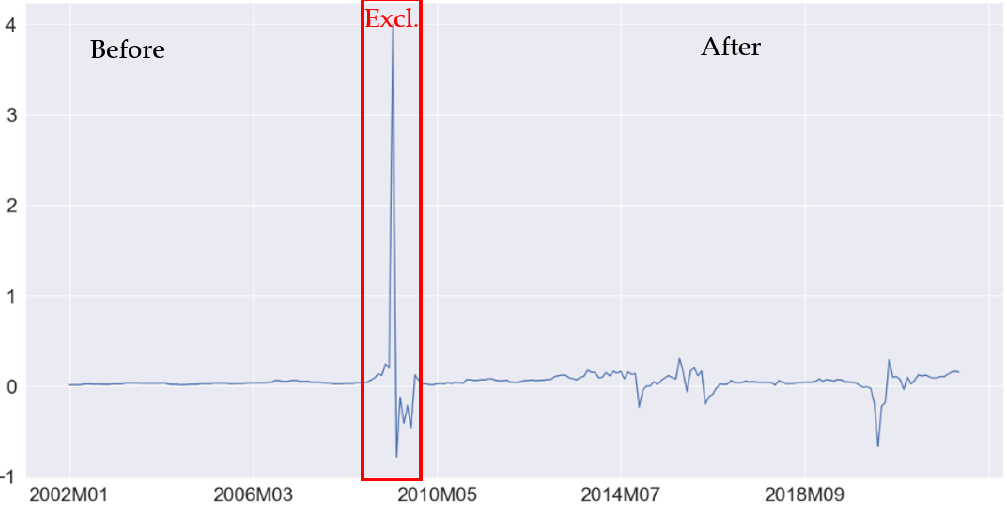
Figure 3. Electricity Share on HICP (El_share) = Electricity contribution/HICP, Source dataset: Figure 3. : Electricity Share on HICP (El_share) = Electricity contribution/ HICP , Source dataset: Eu- Eurostat rostat (5).